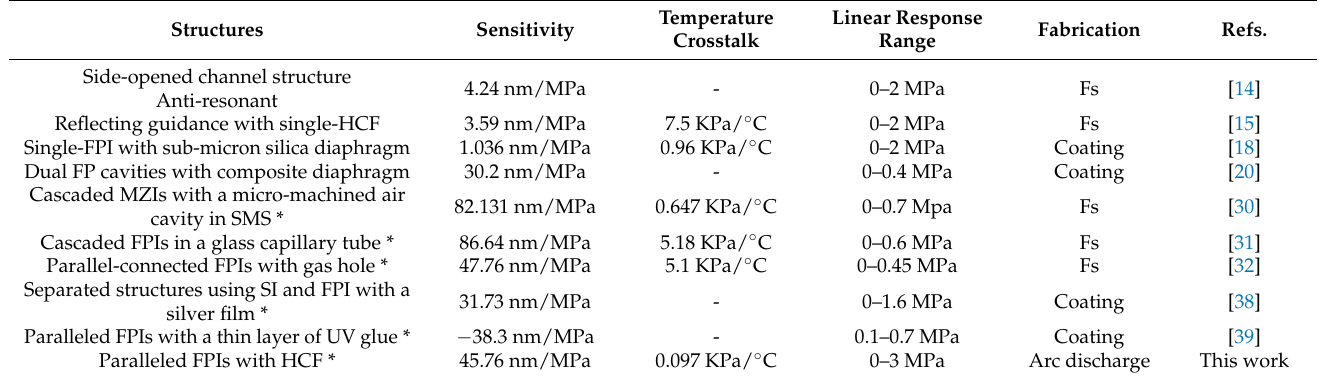
Table 1. Performance comparisons of different gas pressure